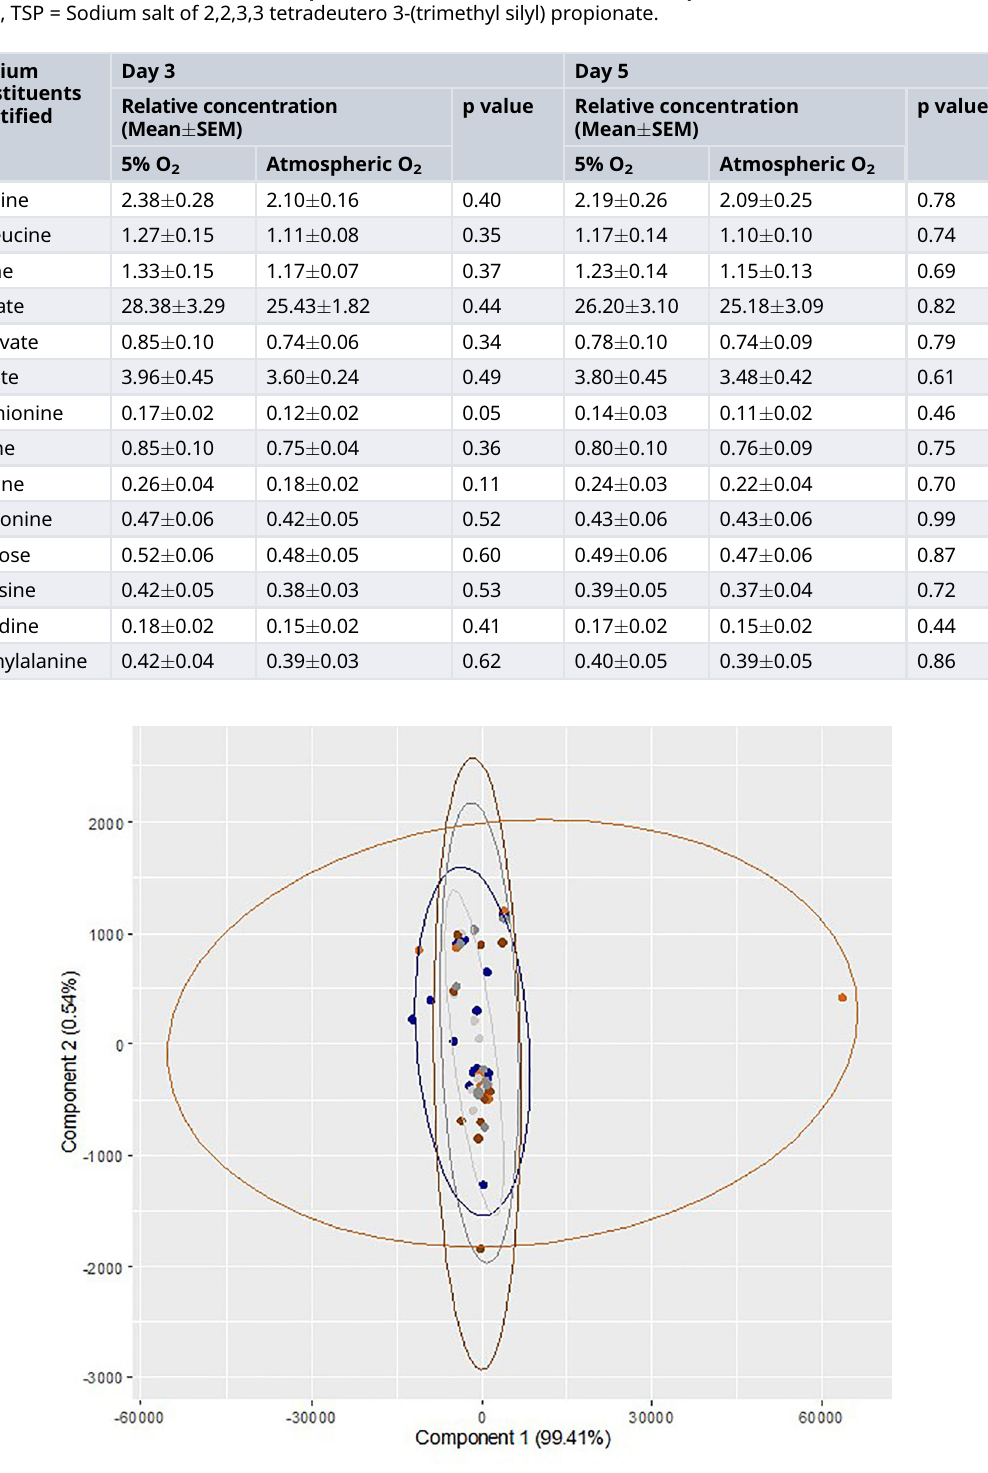
Table 3. Comparison of relative concentration of medium constituents (normalized to TSP) between dry/5% O